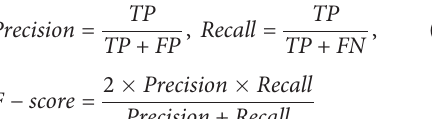
FIGURE 4 | Model probability threshold selection. The objective is to minimize the false positive rate (FPR) and maximize the true positive rate (TPR). This ROC plot (FPR, TPR), illustrates that by minimizing the distance from the point (0,1) to the curve, we are minimizing FPR 2 + (1 - TPR) 2 , thus achieving our objective. The selected threshold corresponds to the FPR and TPR at which the line intersects with the curve minimizing the distance to the point